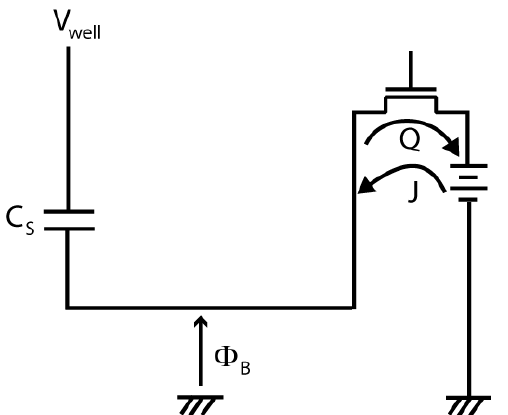
Figure 6. The equivalent